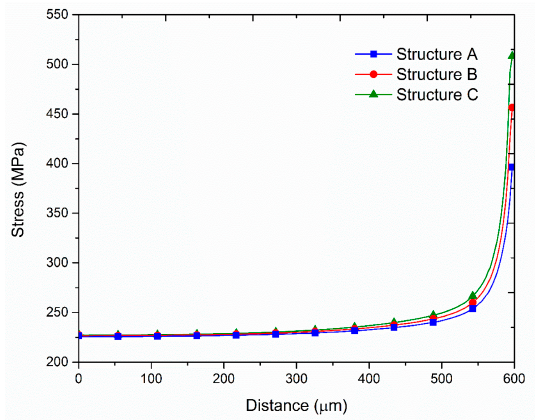
Figure 10. Simulated stress distributions in the cell areas.